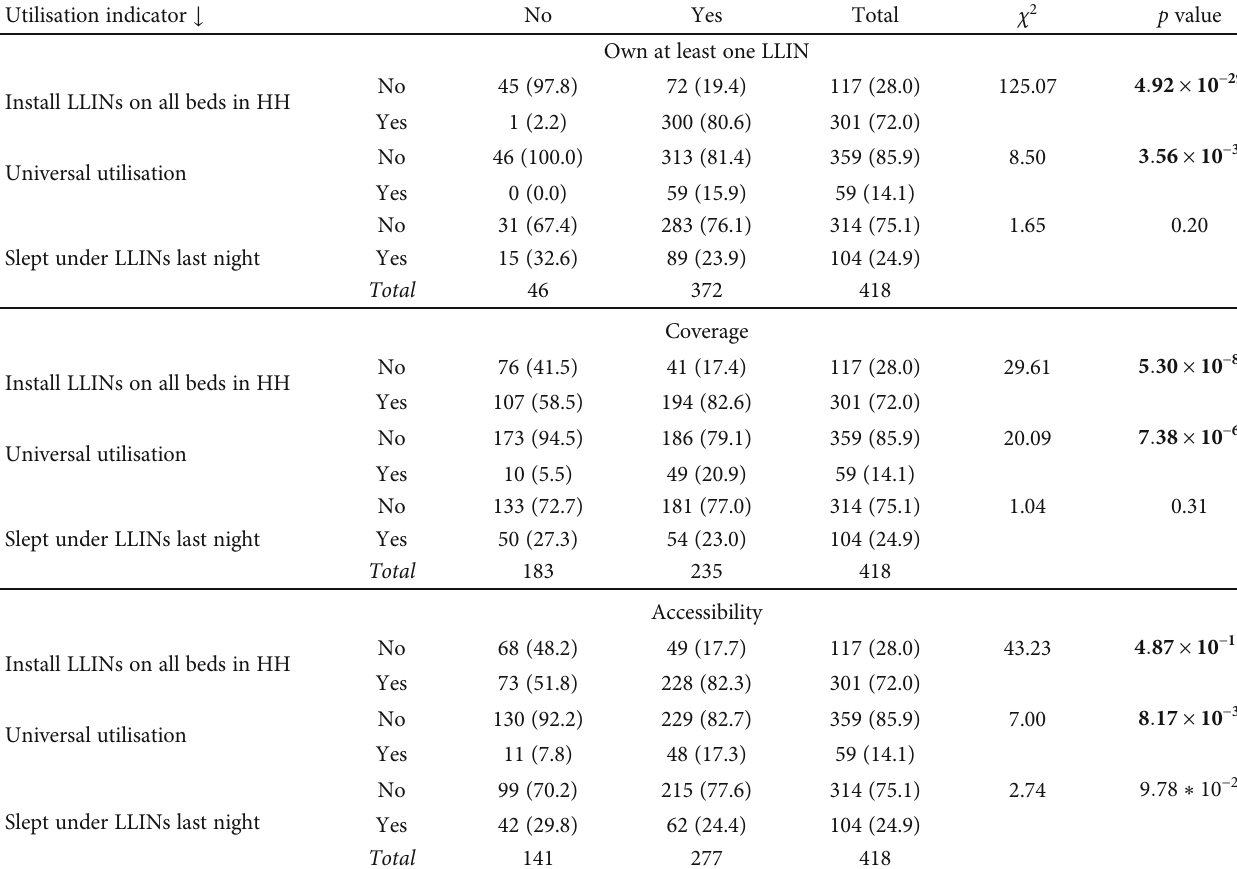
Table 5: Association of LLIN ownership indicators with utilisation